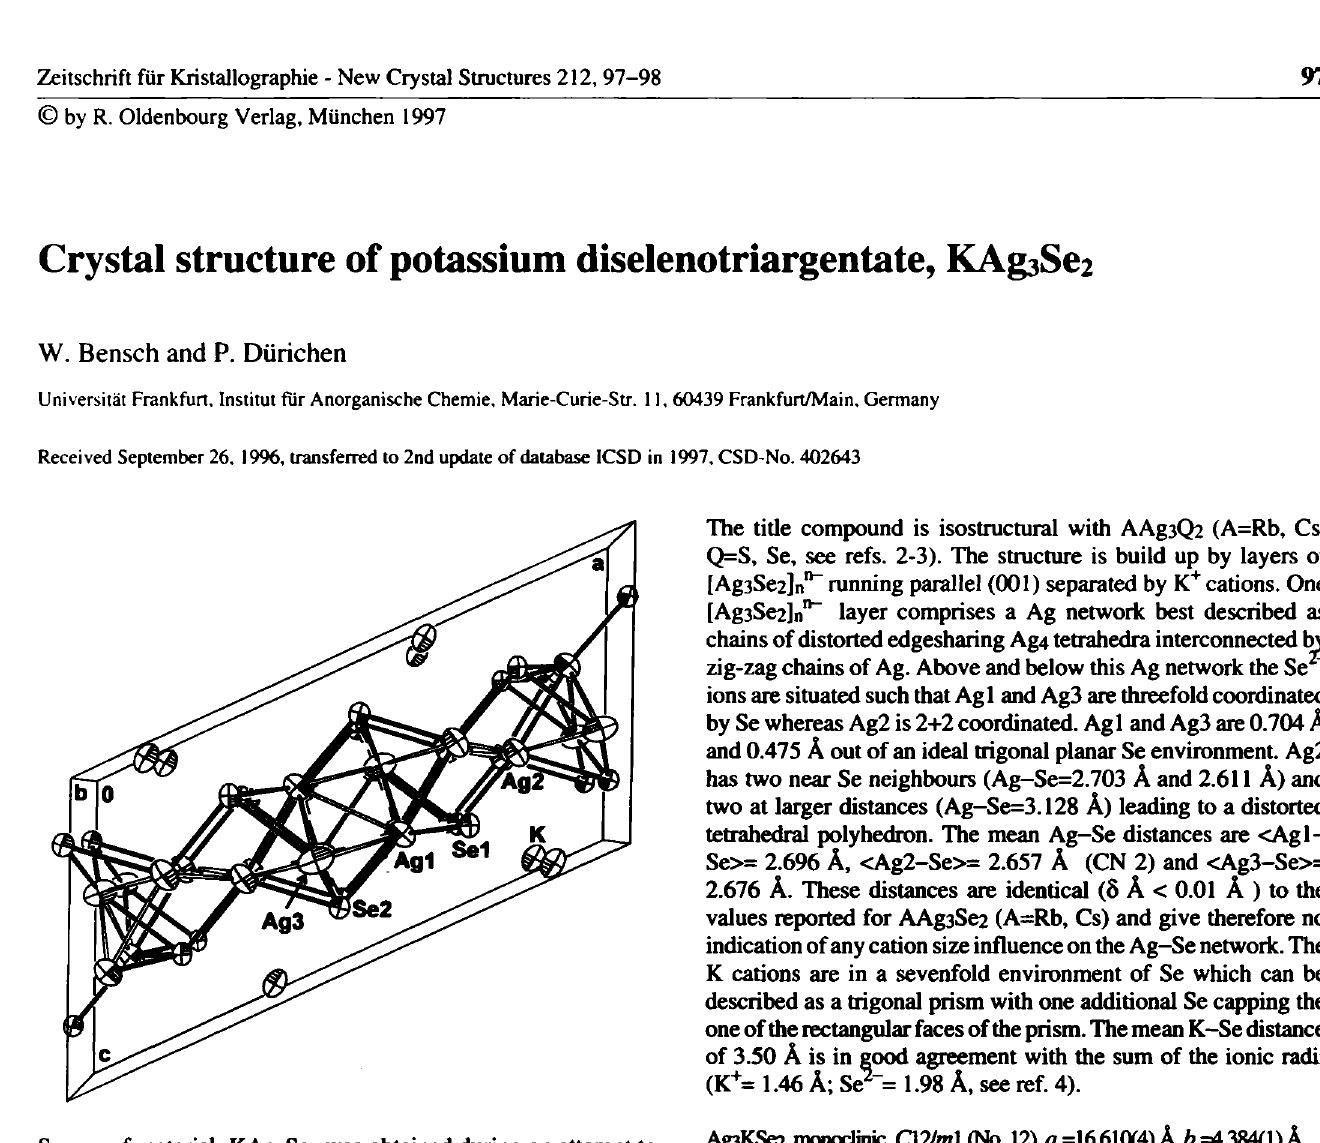
Table 1. Parameters used for the X-ray data collection